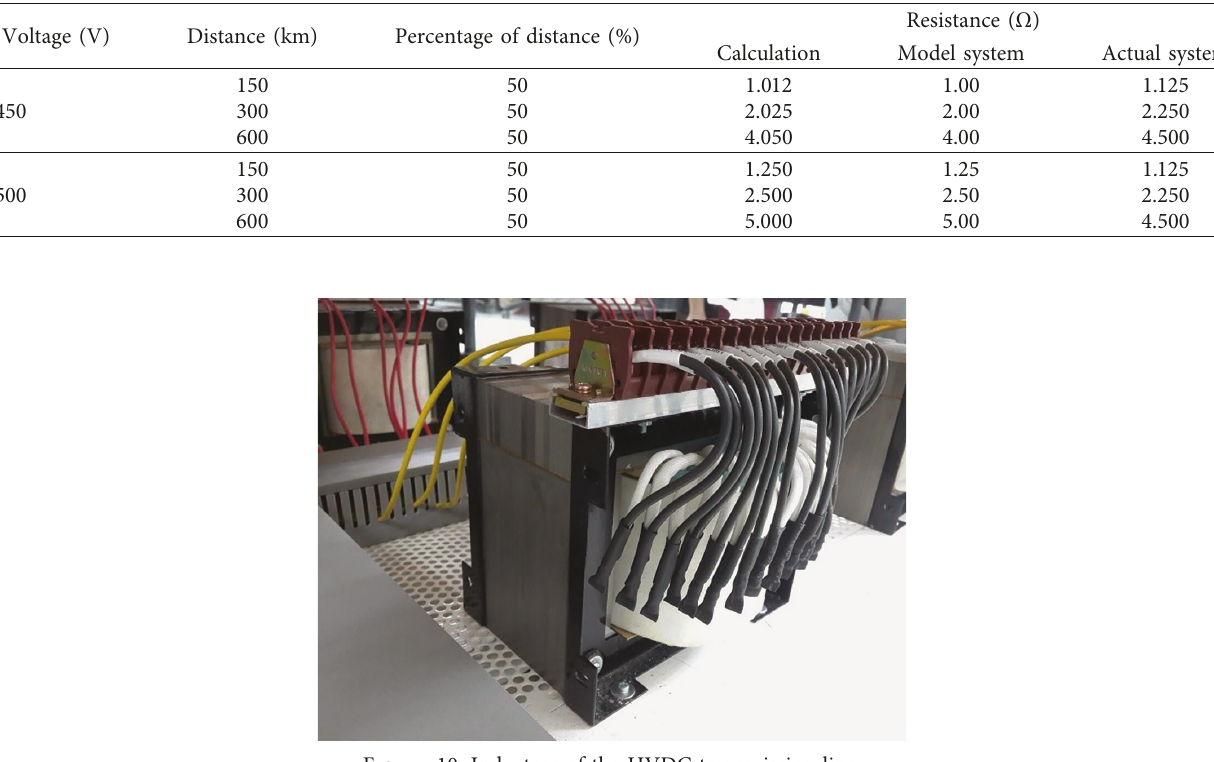
Table 4: Resistance of the HVDC transmission line model at different voltages and distances.